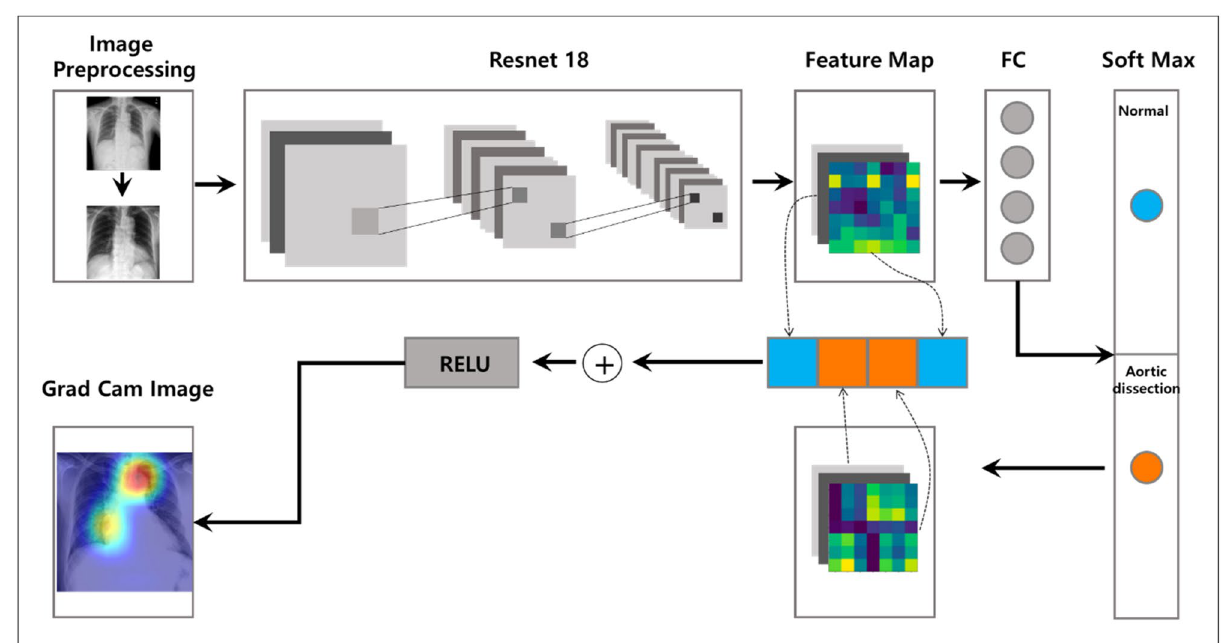
Figure 3. Overview of main architecture used for the diagnosis of aortic